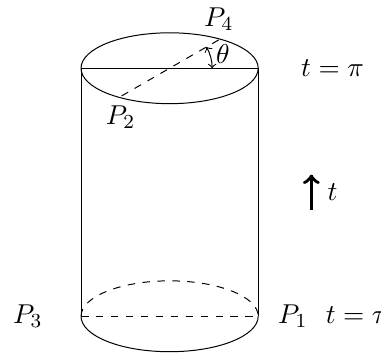
Figure 1 . Insertion points in global